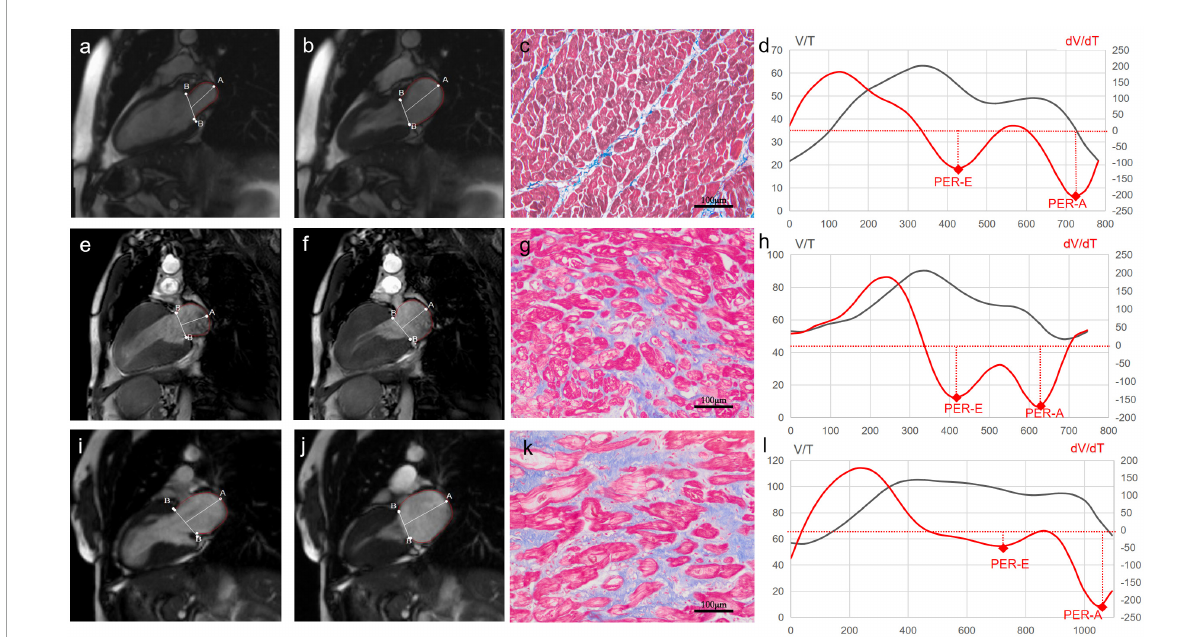
FIGURE1 Cardiac magnetic resonance (CMR) images of left atrial (LA) and histological images of myocardium from a control subject (the top panel), a male patient with hypertrophic obstructive cardiomyopathy (HOCM) (the middle panel), and a female patient with HOCM (the bottom panel). The first column is CMR images of the minimum LA volume after atrial contraction in the two-chambered view (Control: a , Male: e , Female: i ). The second column is CMR images of the maximal LA volume before the mitral valve opening in the two-chambered view (Control: b , Male: f , Female: j ). The third column is the images of myocardial fibrosis (blue) stained with Masson’s trichrome (Control: c , Male: g , Female: k ). The fourth column is volume-time curves (black) and their first derivatives (red) of the left atrium (Control: d , Male: h , Female: l ). LA V/T curves after the first peak and dV/dt curves under the coordinate axis represent the process of LA emptying. The first negative peak, representing maximal emptying during the conduit phase, is identified as the early atrial peak emptying rate (PER-E). The second peak, during the booster phase, is identified as the late atrial peak emptying rate